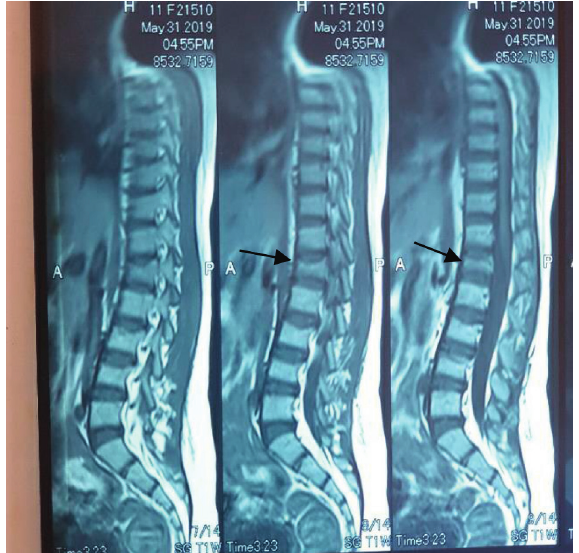
Figure 4: Compression fracture at the L1 vertebra (arrowed), with similar but milder changes in the T11, L3, and L4 vertebrae sug- gestive of a bone softening process due to glucocorticoid-induced osteoporosis and underlying hemoglobinopathy a year and a half into the treatment of her